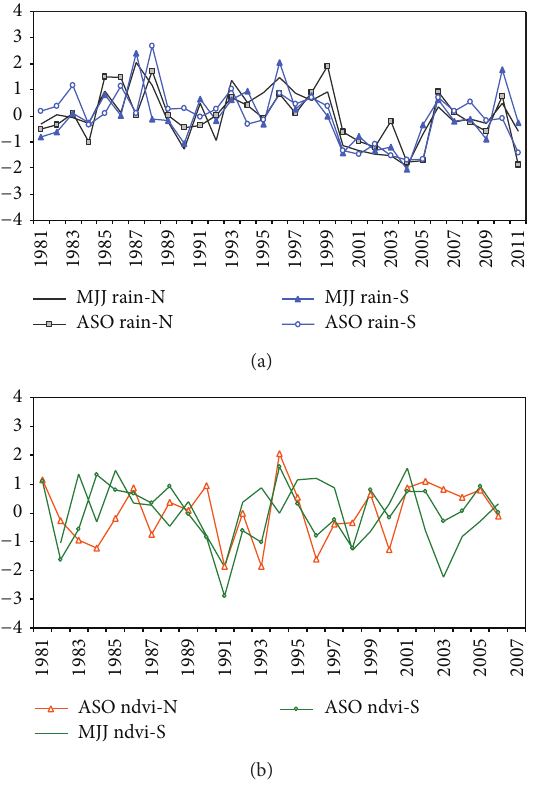
Figure 2: Standardized departures of (a) rainfall and (b) vegetation fraction for two zones in two seasons (MJJ NDVI omitted in